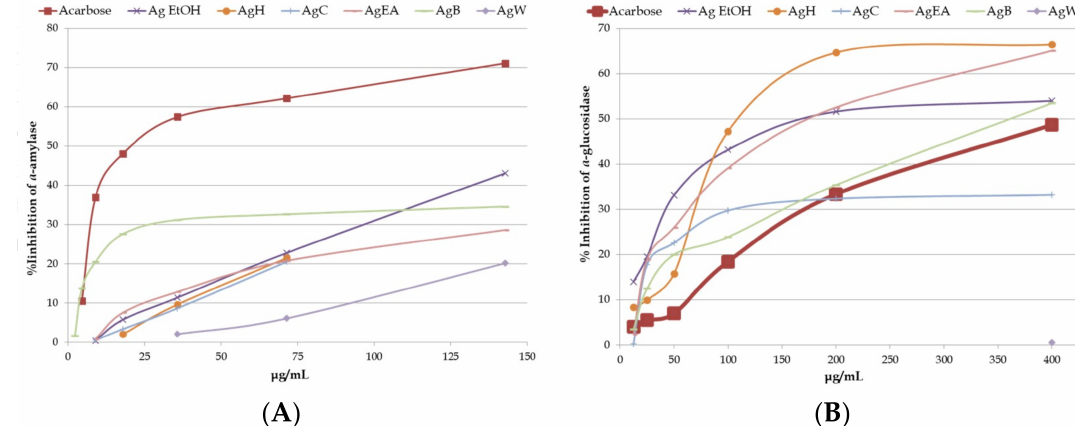
Figure 3. α -amylase ( A ) and α -glucosidase ( B ) inhibition activity of acarbose and Azorella glabra samples. Samples are acarbose, crude ethanol extract (Ag EtOH), n -hexane fraction (AgH), chloroform fraction (AgC), ethyl acetate fraction (AgEA), n -butanol fraction (AgB), and water fraction (AgW). Data are mean ± standard deviation from three experiments performed in